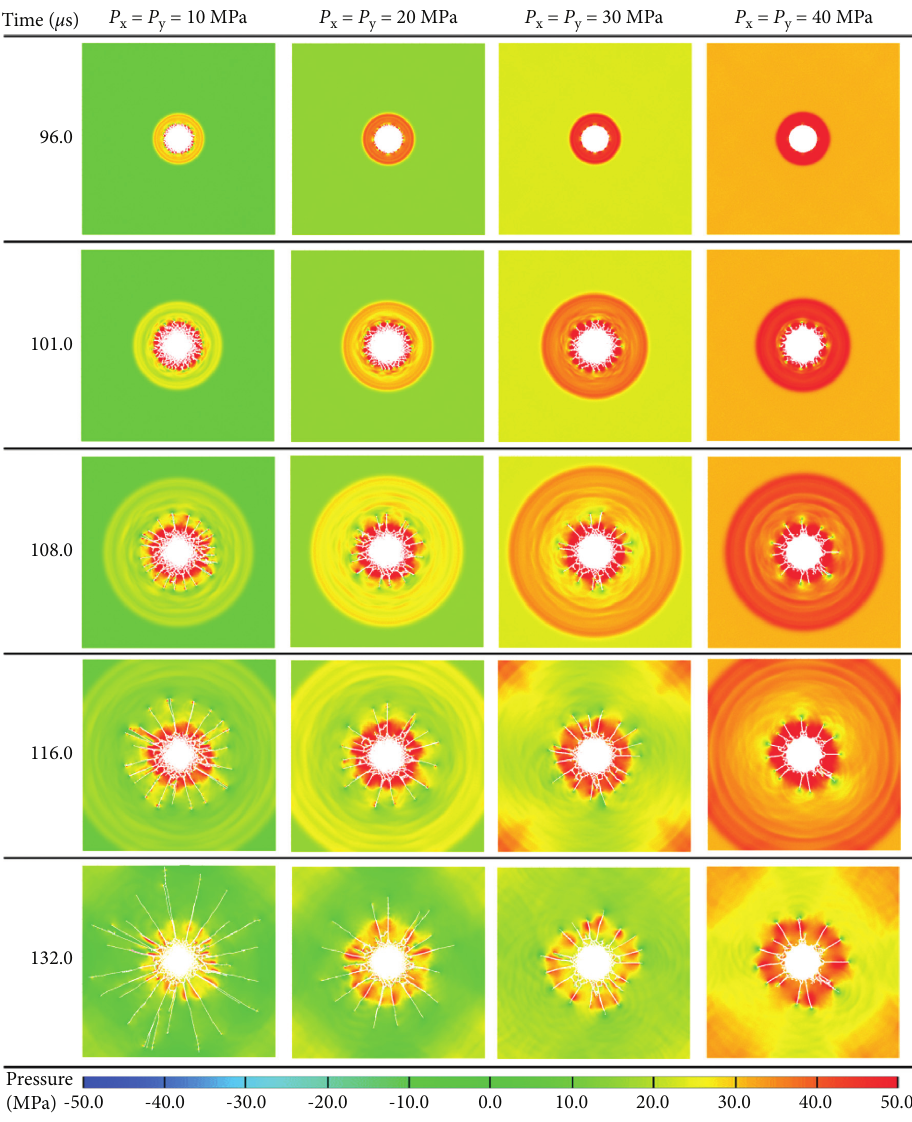
Figure 9: Pressure contours versus time under different